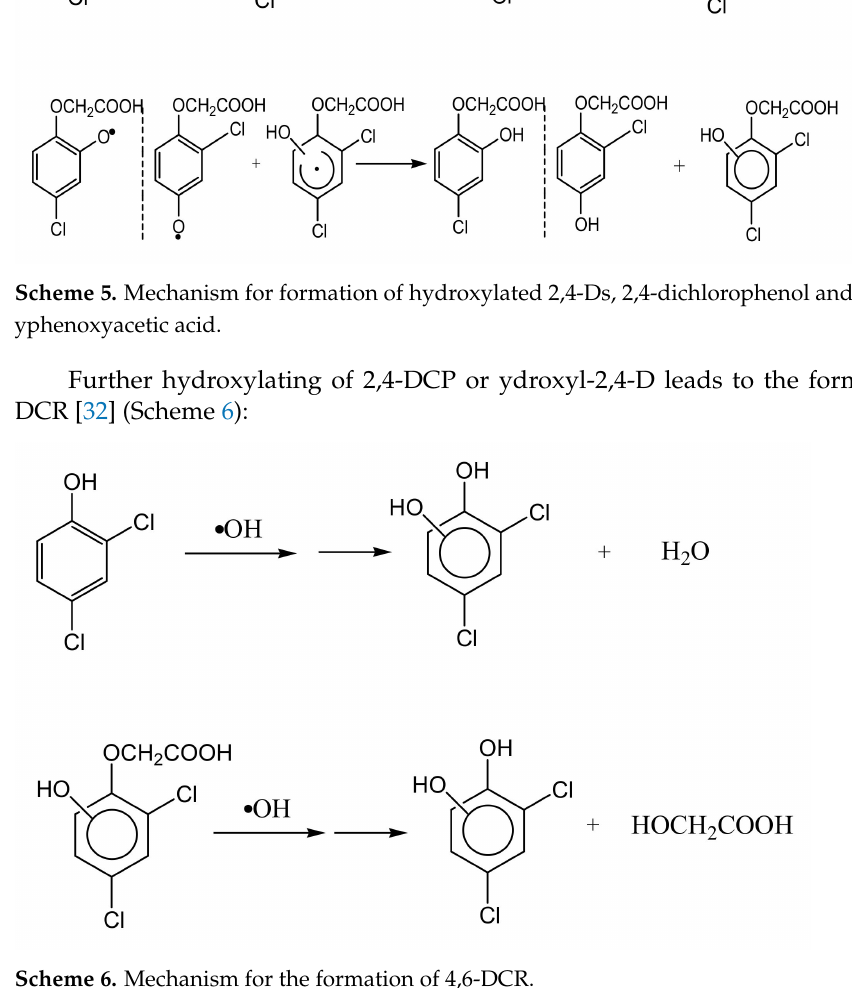
Scheme 6. Mechanism for the formation of